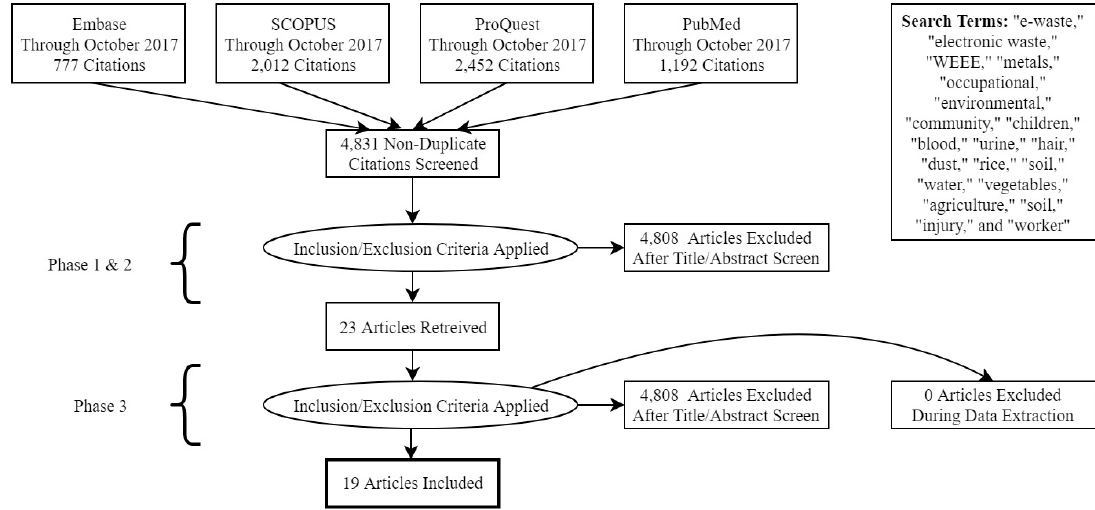
Figure 1. Flow diagram illustrating database search and study selection methodology.